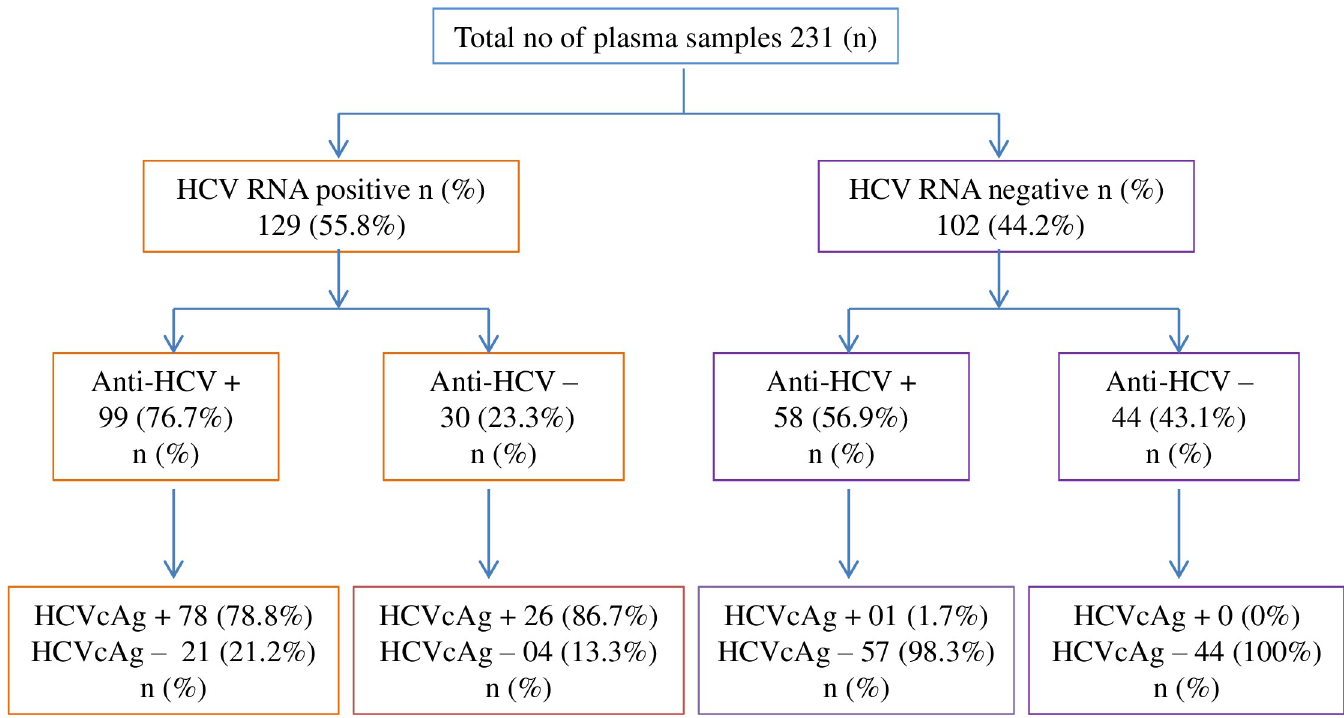
Fig 2. Classification of samples based on assay